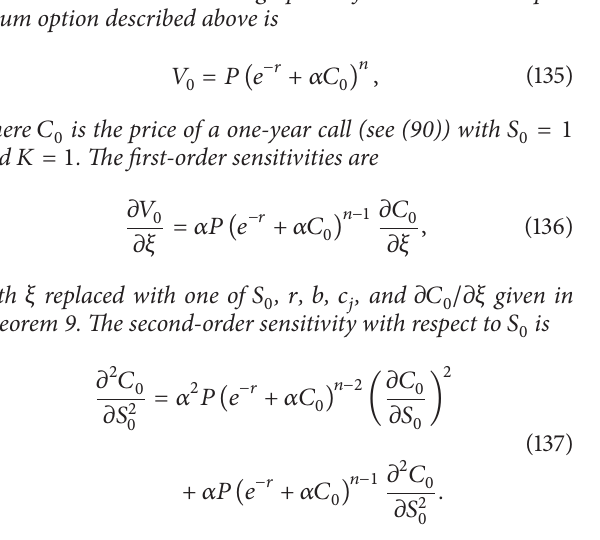
Figure 3: Feasible region for the skewness and excess kurtosis of the GC (𝑎, 𝑏; 0, 0, 𝑐 3 , 𝑐 4 ) distributions and maximum likelihood estimate.